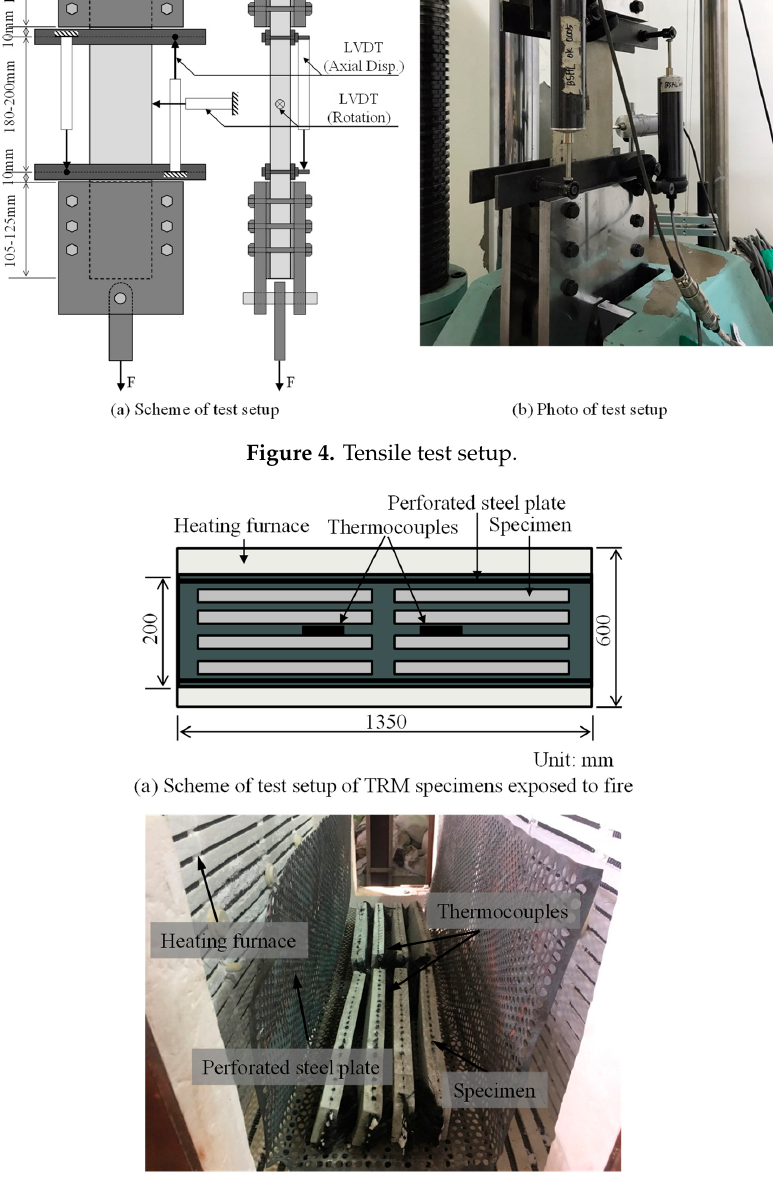
Figure 5. Test setup of textile-reinforced mortar (TRM) specimens exposed to fire.